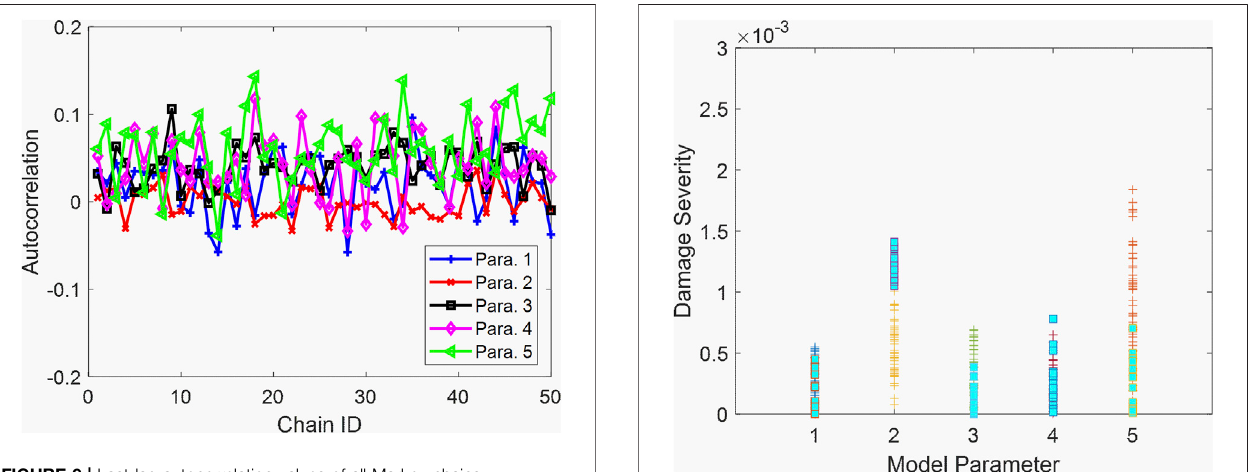
FIGURE 9 | Last-lag autocorrelation values of all Markov chains.